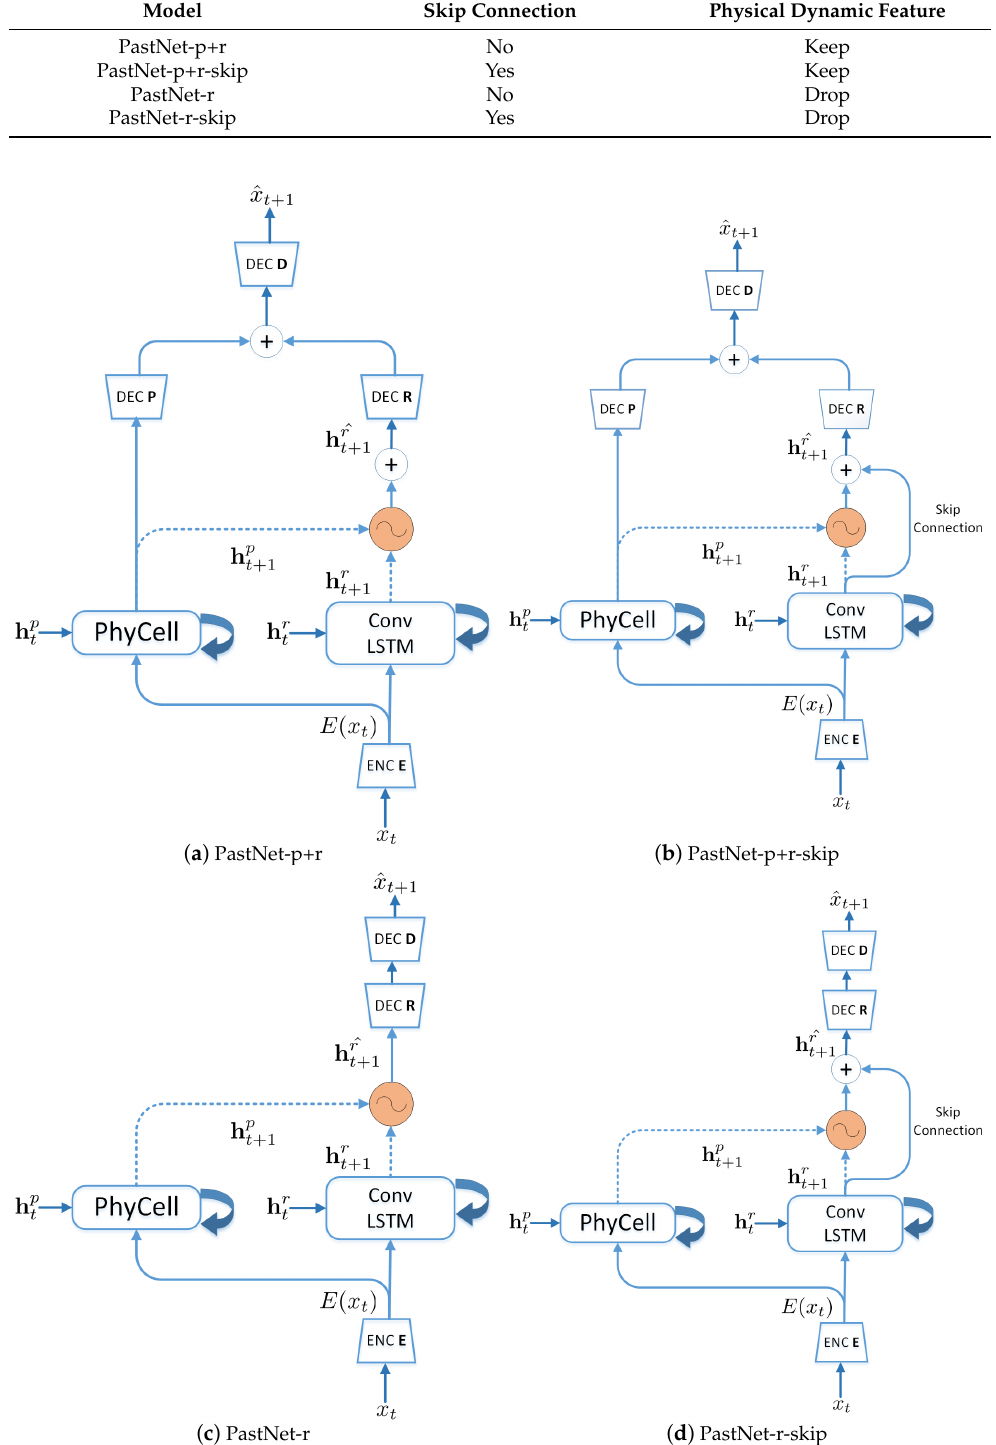
Figure 3. Four versions of PastNet. PastNet-p+r adds h p skip has a skip connection from h r keeps h r to feed into the final decoder. PastNet-r-skip adds a skip connection between h r t + 1 ˆ h r on t + 1